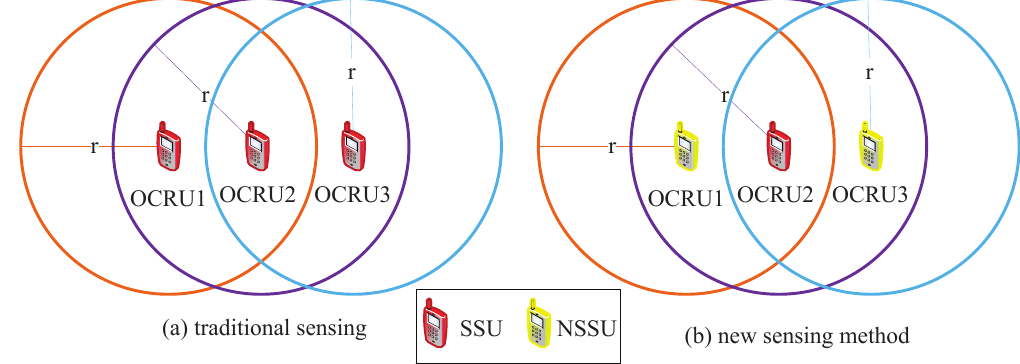
Figure 4. Sensing model. ( a ) traditional sensing, ( b ) new sensing